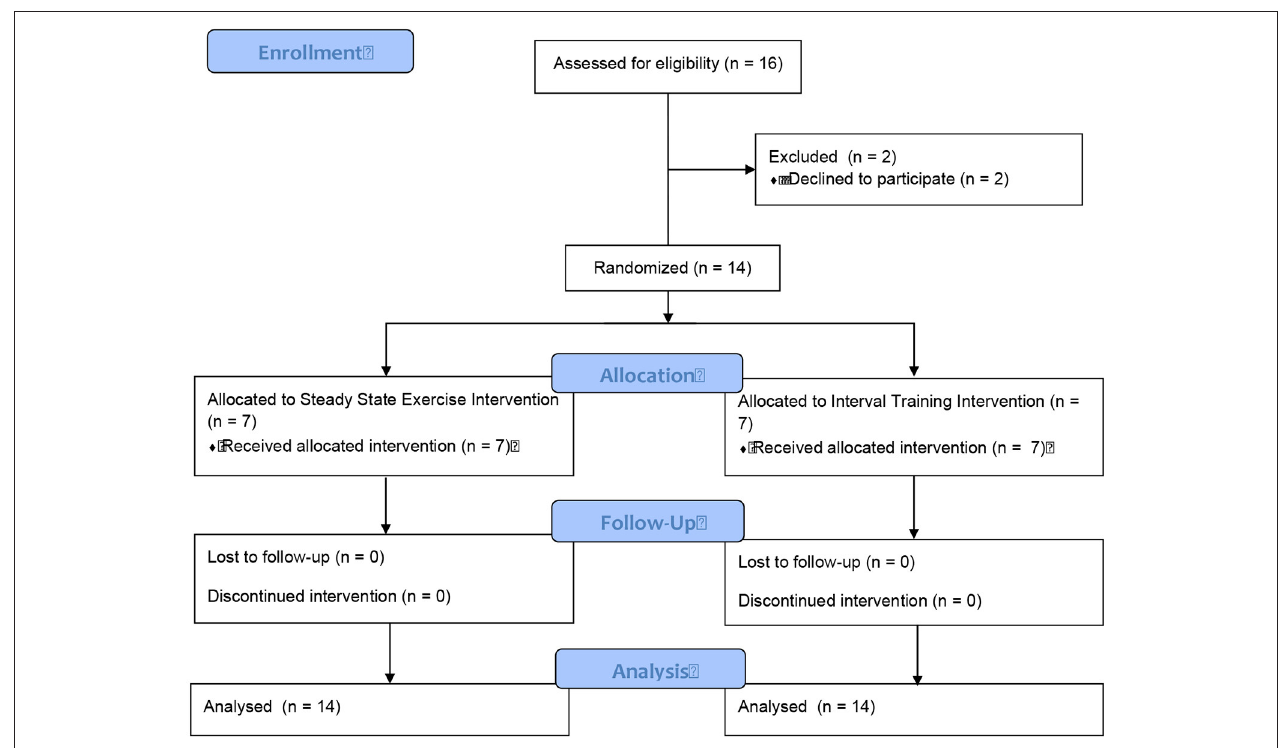
FIGURE 1 | Study flow